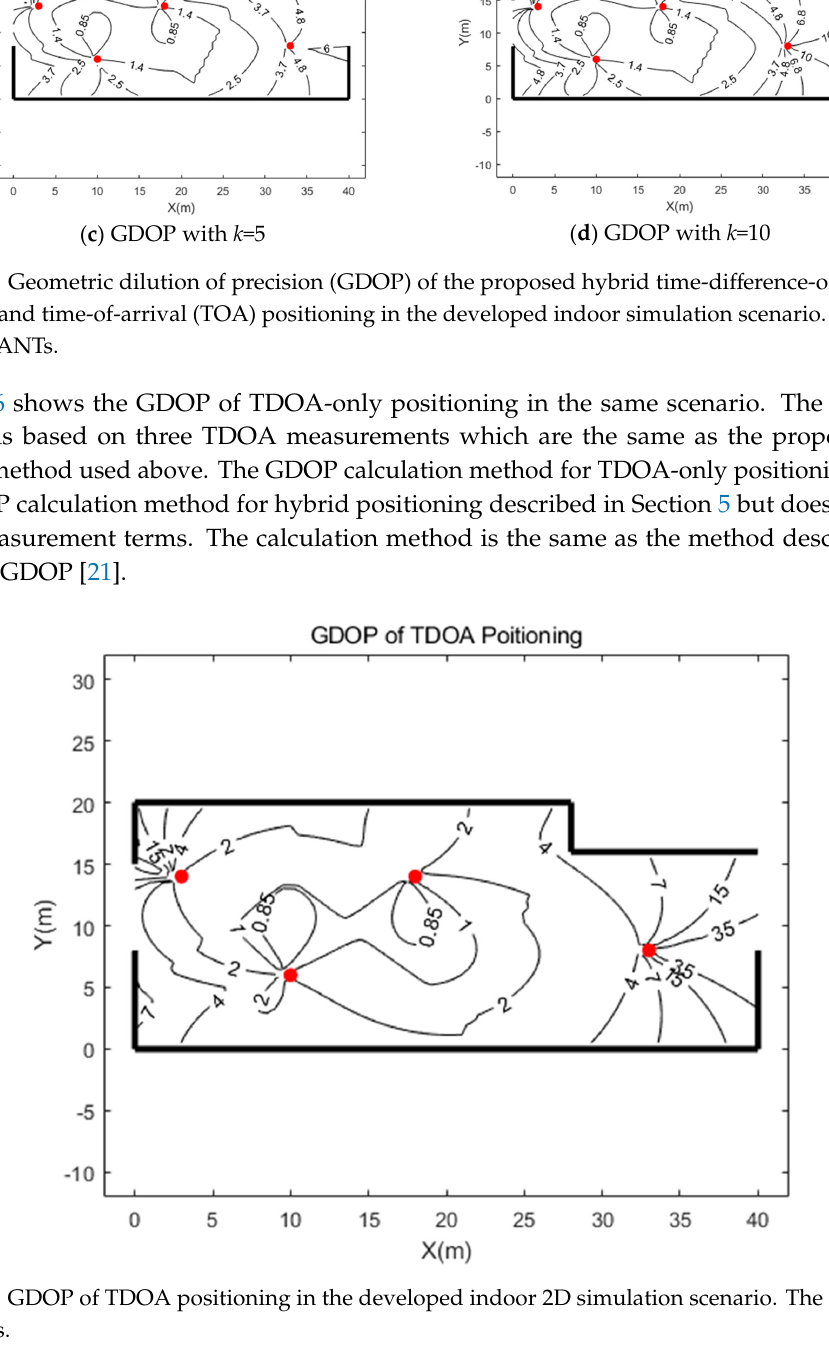
Figure 7. The cumulative distribution function (CDF) of different positioning methods GDOPs at all selected points. From Figure 7, it is obvious that the GDOP values of the proposed hybrid positioning are significantly lower than the TDOA-only positioning. It can be seen in (16) that the greater the ratio k is, the smaller the weight of the TOA ranging error item in the weighting matrix (18) is, and the closer